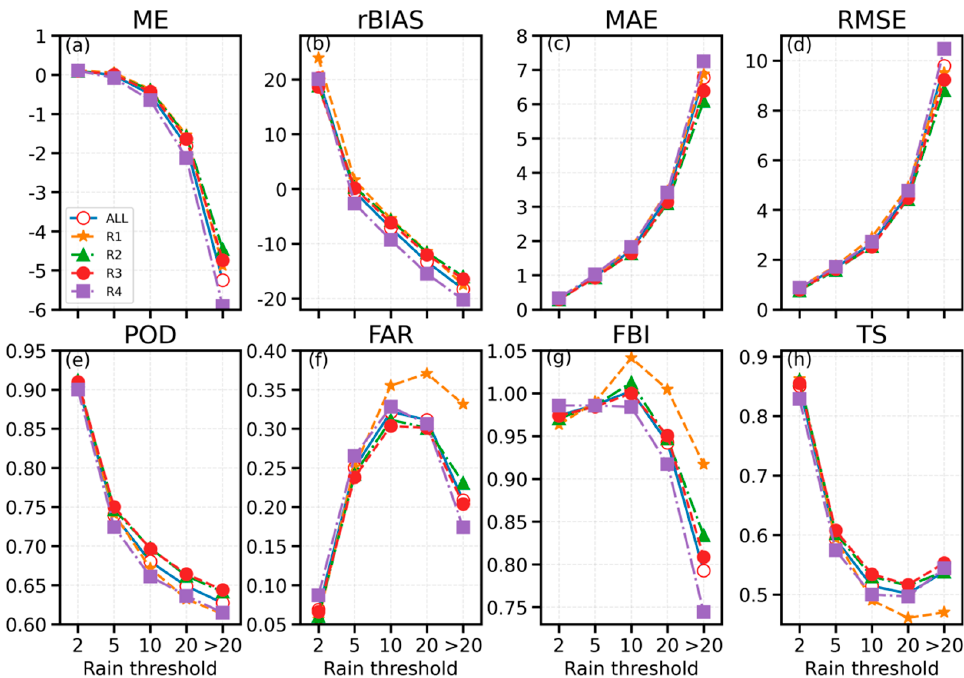
Figure 10. Statistics of the evaluation results of the CMPAS–NRT product under different hourly precipitation threshold intervals (including each sub–region and the whole region) in the Meiyu monitoring area during the 2020 rainy season. Panels ( a – h ) respectively represent the ME, rBIAS, RMSE, CORR, POD, FAR, FBI, and TS.